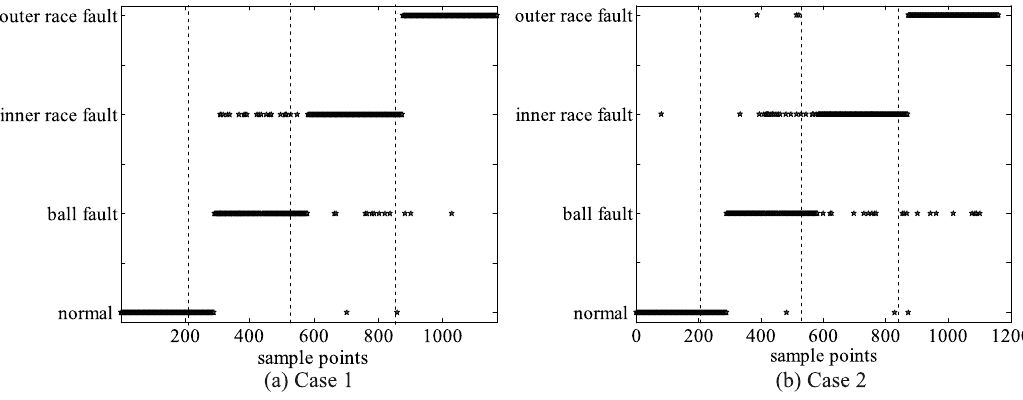
Fig. 8. Identification results of rolling bearings four